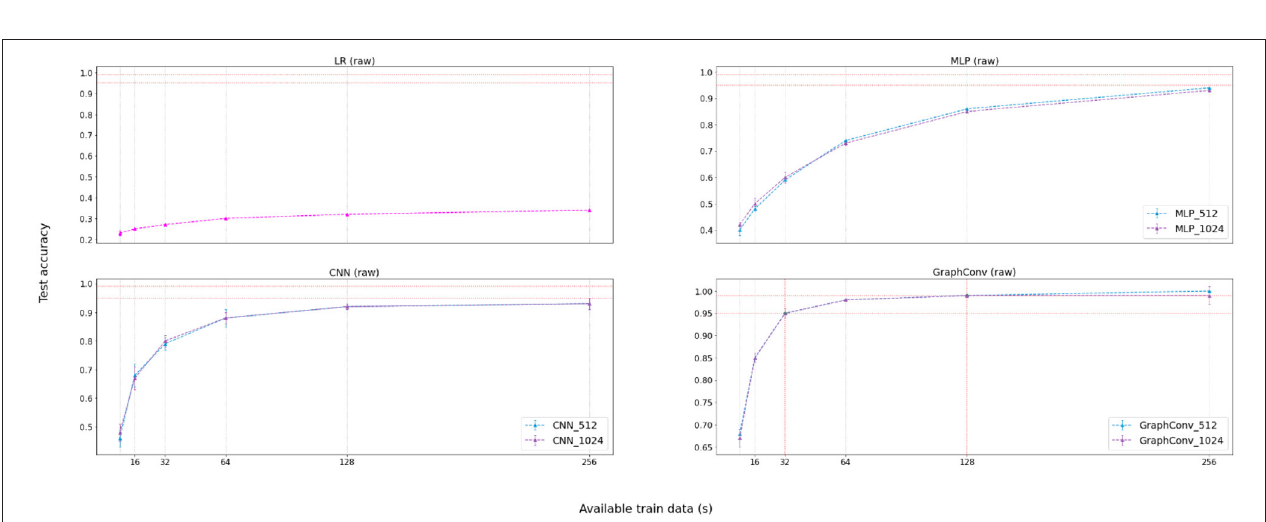
FIGURE 6 | Results visualization for the no-feature extraction (raw) phase. Graphs represent accuracy against available training data for each participant (in seconds). There exists a legend accompanying non-linear approaches and displaying the number of hidden channels.